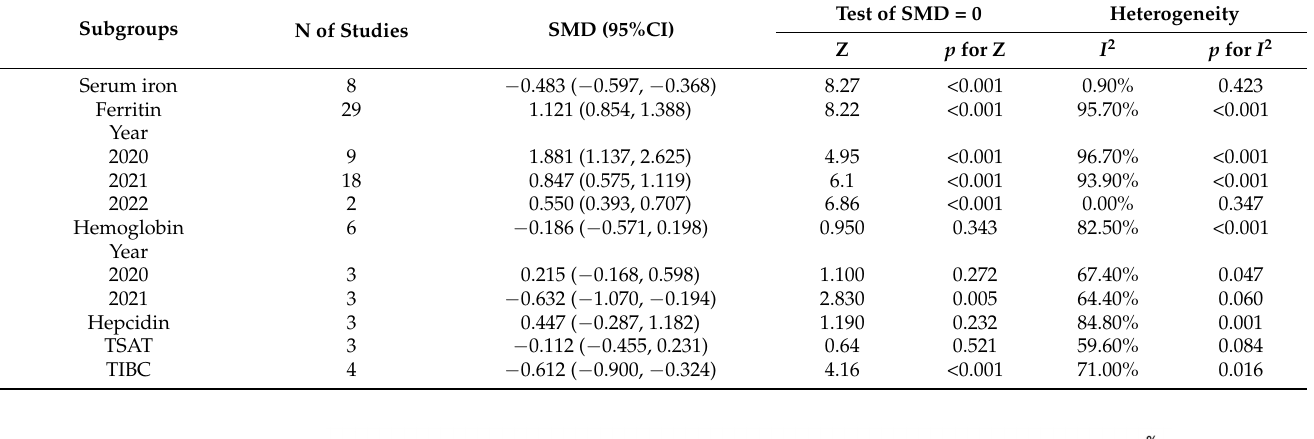
Table 2. Subgroup analyses of studies on the associations of iron-related biomarkers with mortality in SARS-CoV-2 patients.